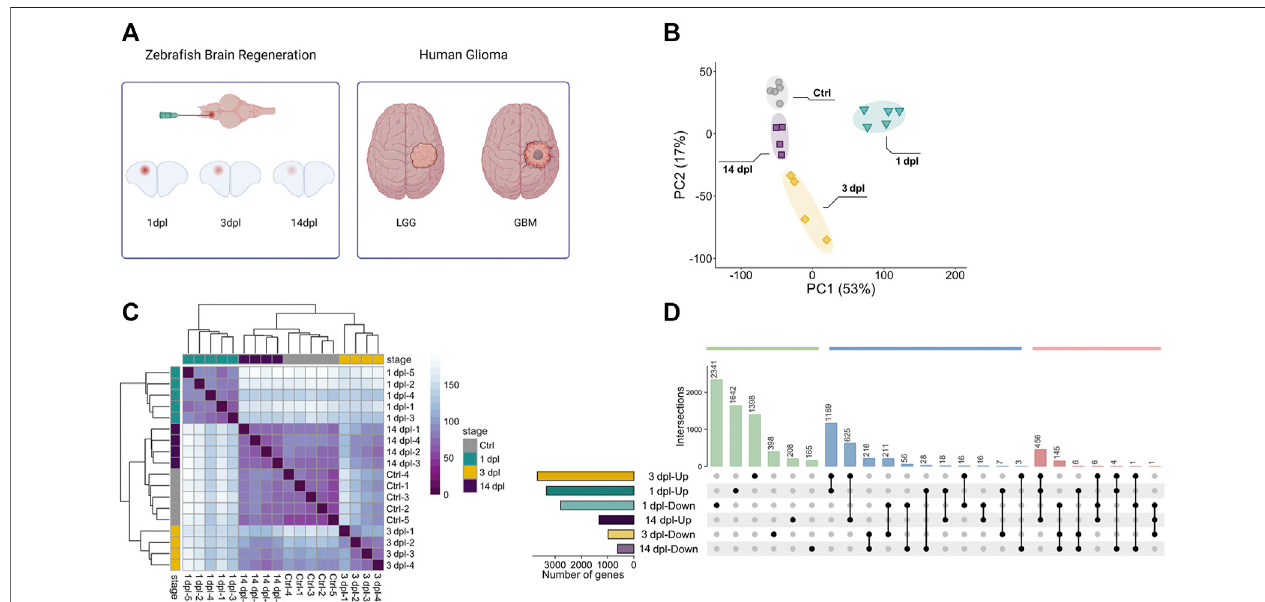
FIGURE1| Sample preparation from threedifferentstages ofzebra fi shbrainregenerationand initial analyses ofthetranscriptomedata. (A) Generationofthe stab lesion and preparation of the RNA samples from lesioned hemispheres at 1, 3 and 14 dpl. Transcriptomes of the regenerating brain were compared to those of human adult LGG and GBM. (B) Principal component analysis (PCA) of three brain regeneration stages and their controls. Different colors of circle, square or rectangle dots represent the four groups of samples. Four or fi ve dots with the same color refer to the biological replicates of a sample group. Four sample groups were well clustered among their replicates and well separated from other sample groups. (C) Sample-to-sample distance heatmap generated by using normalized counts for overall gene expression patterns for three stages of brain regeneration and control brain samples generated by the DESeq2 package. Different colors of dots represent the four groups ofsamples. (D) UpSet plot shows the comparison of DEG sets between regeneration stages. Total number of DEGs as Up or Down and time points are shownon x and y axes,respectively.Greenbarsrepresentthegenesuniquetoatimepoint,bluebarstheintersectionofgenesbetweentwodifferenttimepointsandred bars the intersection of genes between three different time points. Black dots connected by lines correspond to the time point and Up/Down state. Numbers of overlapping genesare shown above each bar. dpl:days post-lesion, ctrl: control, LGG: low-grade glioma, GBM: glioblastoma, Up:upregulated, Down: downregulated.